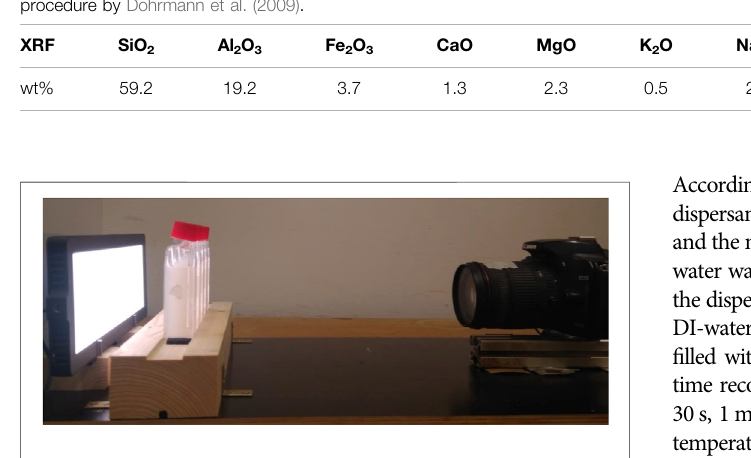
FIGURE 1 | Experimental setup to determine the CCC. The distances between the light panel and the bottles, and the bottles and the camera are 7.5 and 28.5 cm,